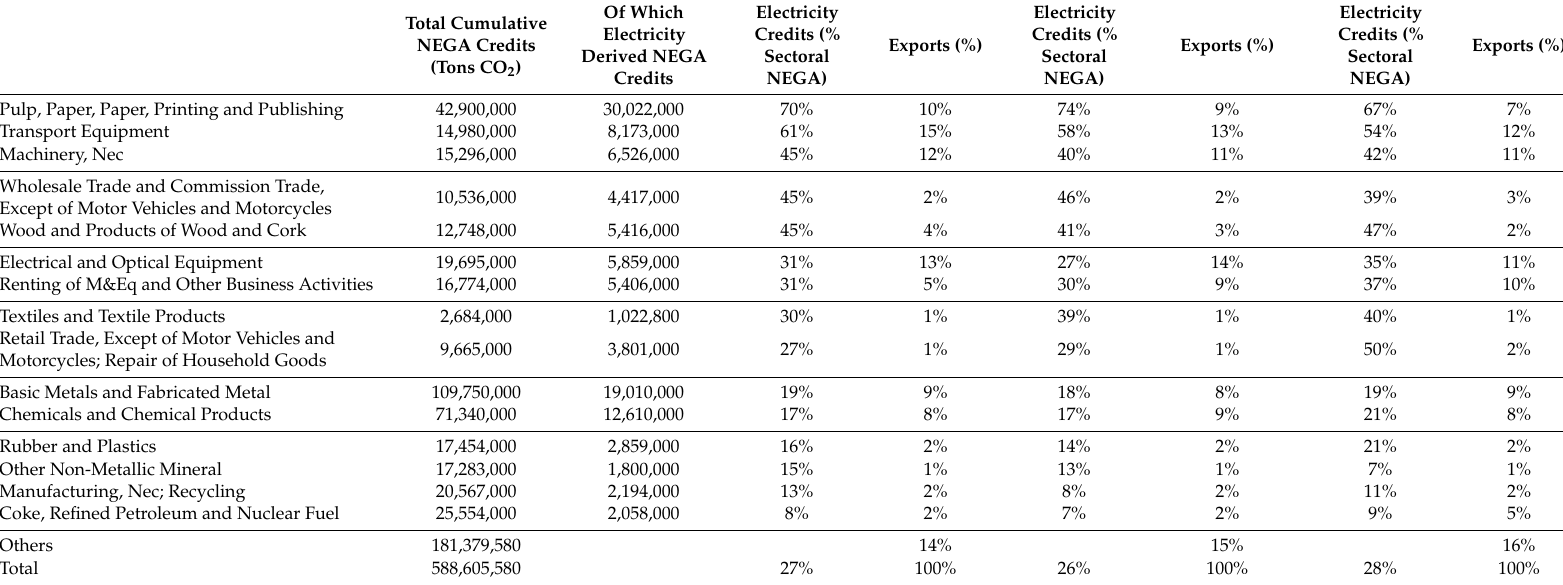
Table 1. The sectoral dependence on low-carbon electricity in total NEGA credits (relative share of electricity NEGA credits in total sectoral NEGA credits). Note: Selected sectors only. Exports (%) relates to percentage share of total Swedish exports in respective year (measures in monetary